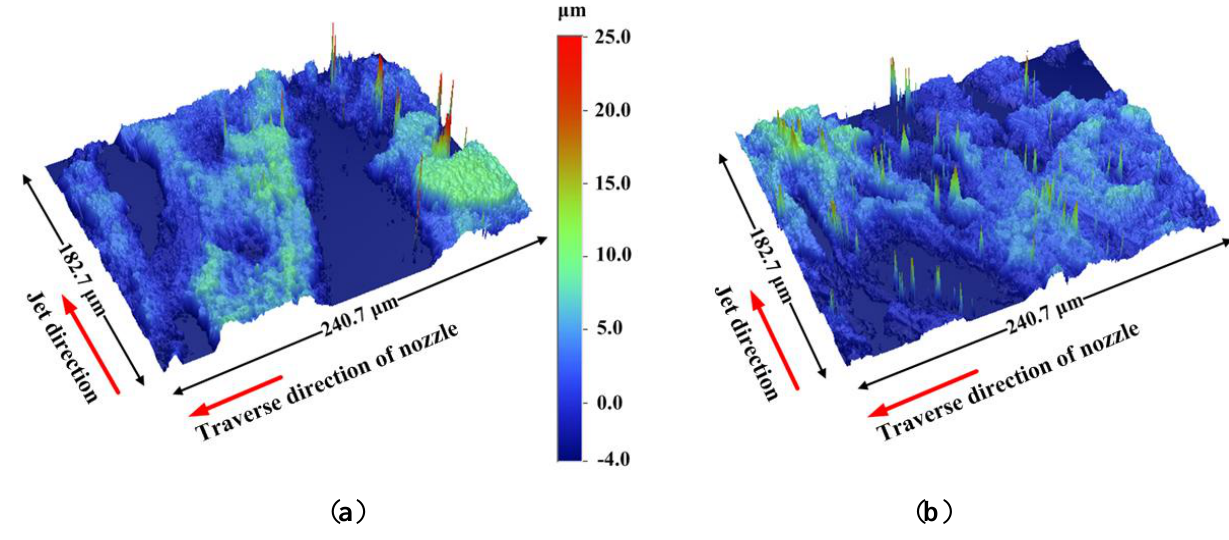
Figure 8. Three-dimensional surface morphological features: ( a ) Z = 3.0 mm; ( b ) Z = 7.0